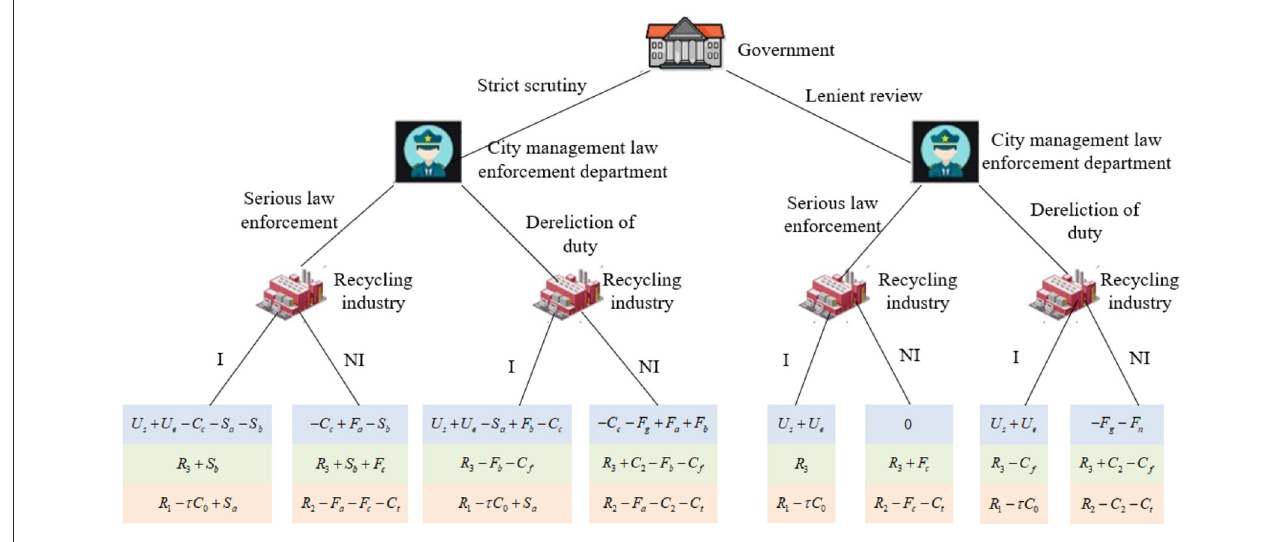
FIGURE2 Government, city administration, and recycling industry game